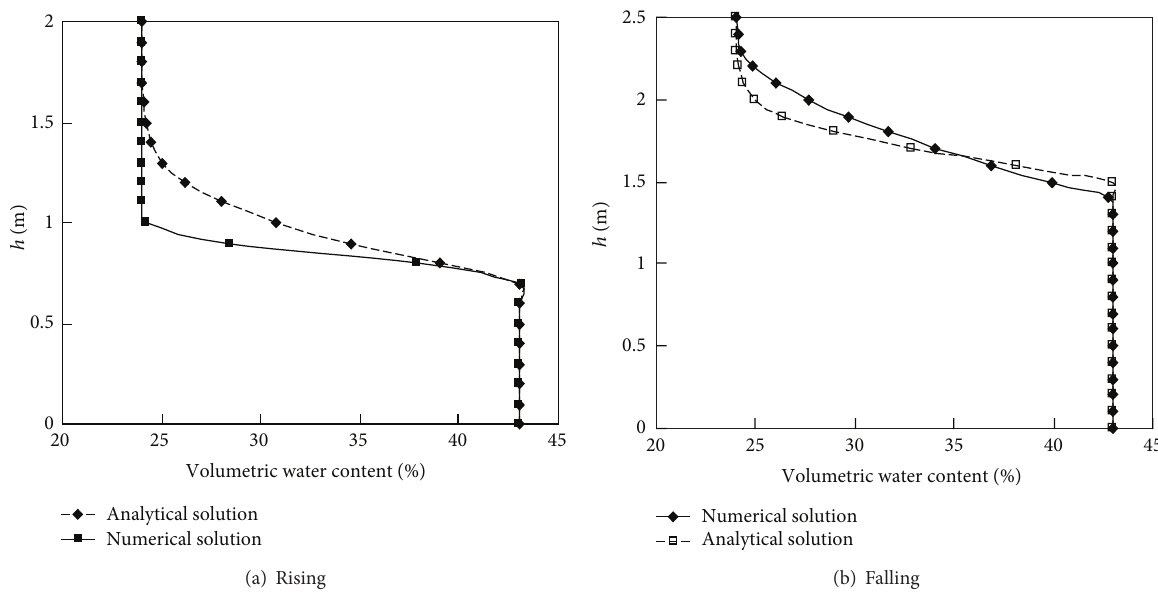
Figure 4: Comparison of numerical and analytical methods for solving subgrade moisture variations under groundwater fluctuations.